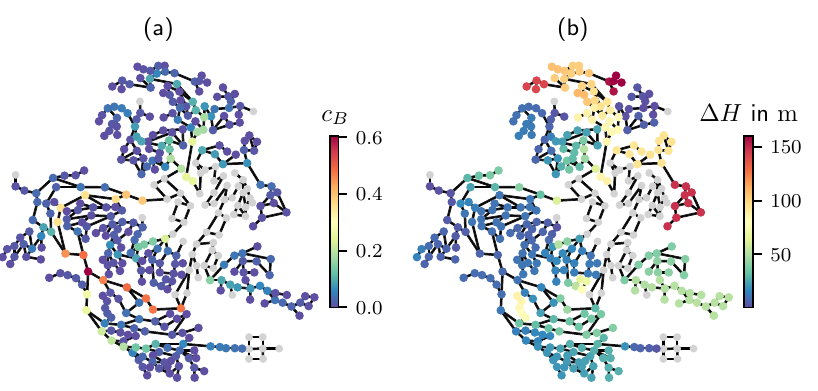
Figure 6. Results of the graph-based resilience metrics. ( a ) betweenness centrality, ( b ) shortest hydraulic paths